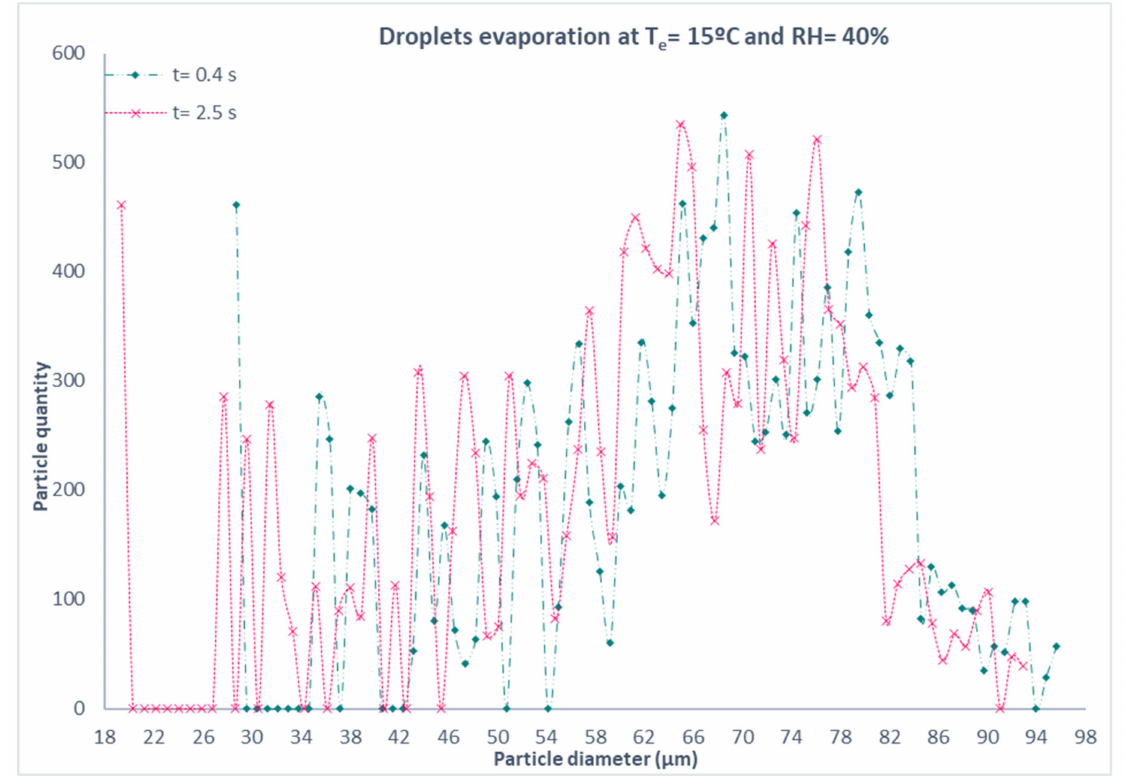
Figure 6. The distribution of the droplets size at t = 0.4 s and t = 2.5 s when the environment temperature was 15 ◦ C and the relative humidity was